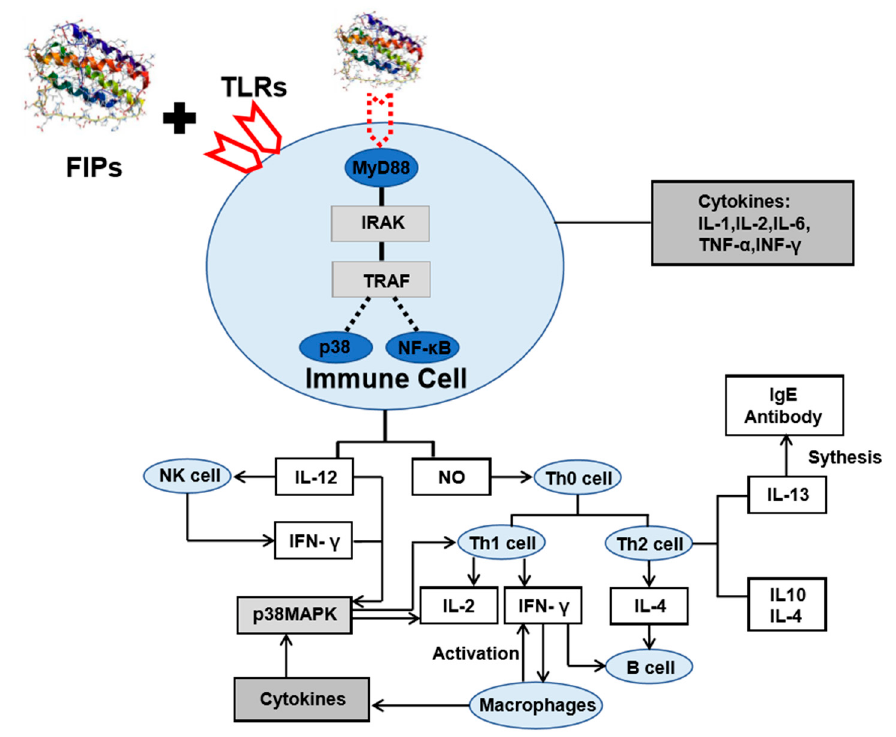
Figure 5. FIPs immunomodulatory mechanism by toll-like receptors (TLRs) signaling pathway.